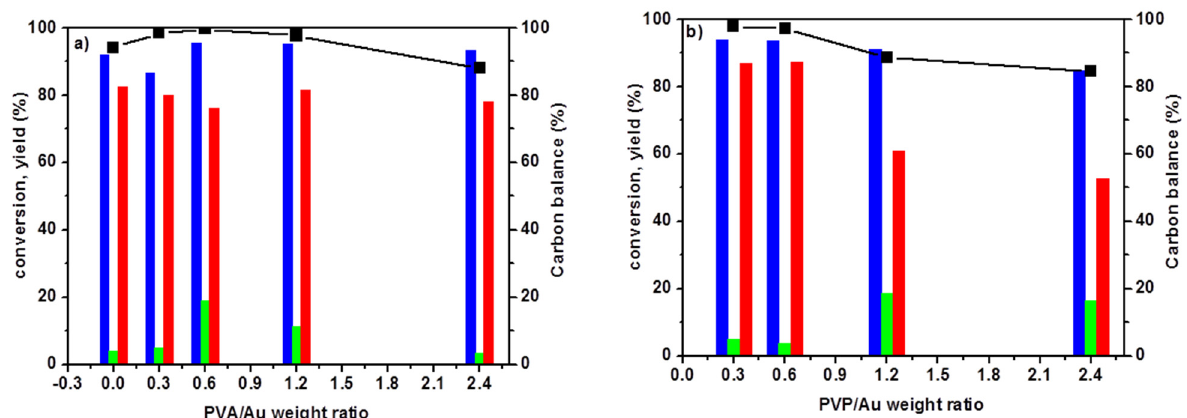
Figure 3. Conversion and yield to products as function of ( a ) PVA and ( b ) PVP stabilizer in the presence of NaOH: ( ■ ) HDO conversion, ( ■ ) AA yield, ( ■ ) HHA Yield, ( ■ ) Carbon balance. Reaction conditions: 2 mL solution of HDO (42 mmol L − 1 ), nHDO/nAu =250, 110 °C, 15 bar air, 4 h, 600 rpm, nNaOH/nHDO = 3.